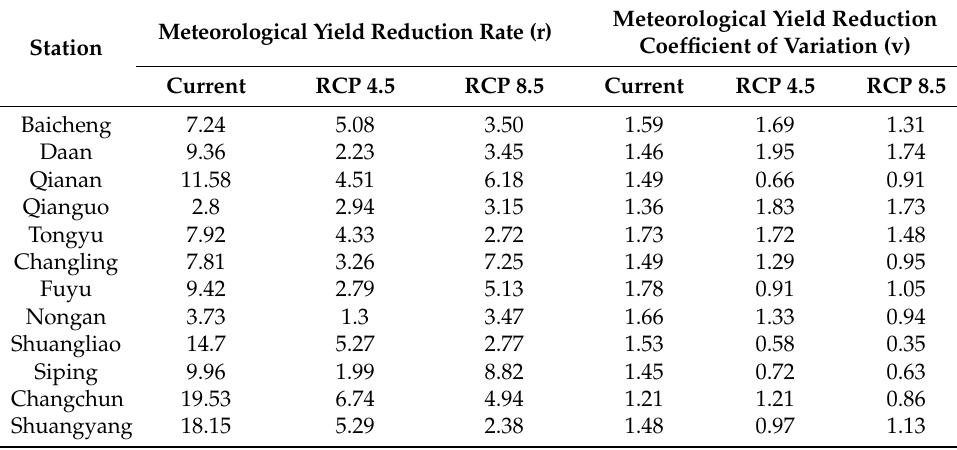
Table 3. Level of maize disaster risk in midwestern Jilin